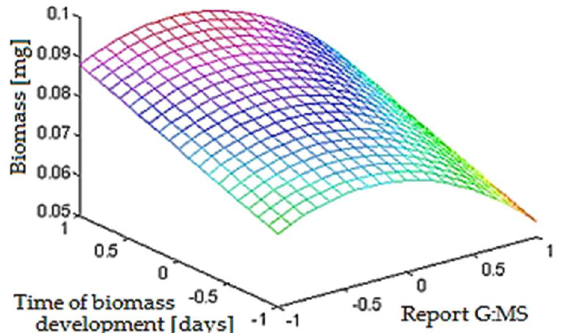
Figure 3. The influence of the time of development of the biomass and the report between glucose and modified starch when the report between glucose and starch is maintained in the field centers .